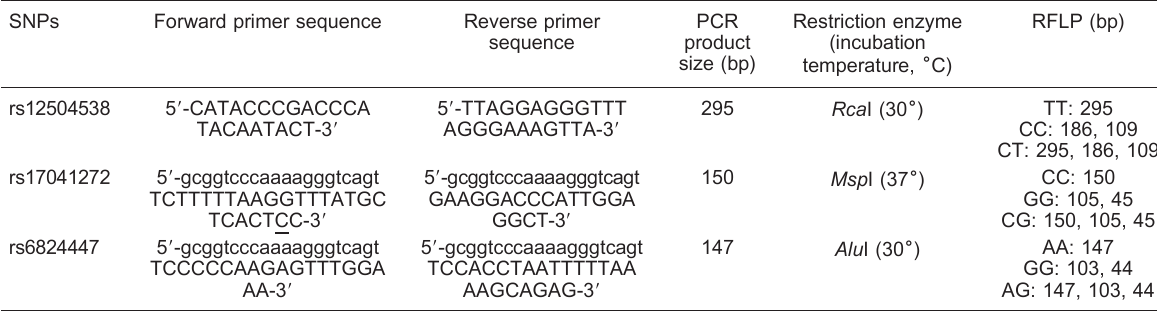
Table 1. Information for the SNPs of the ELOVL6 gene studied here.